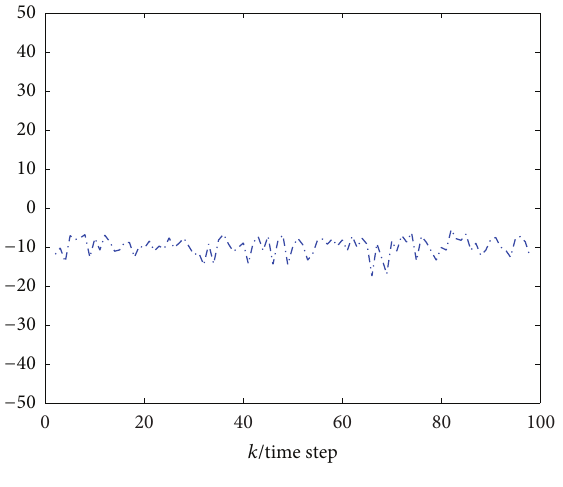
Figure 8: log(MSE2) (Case